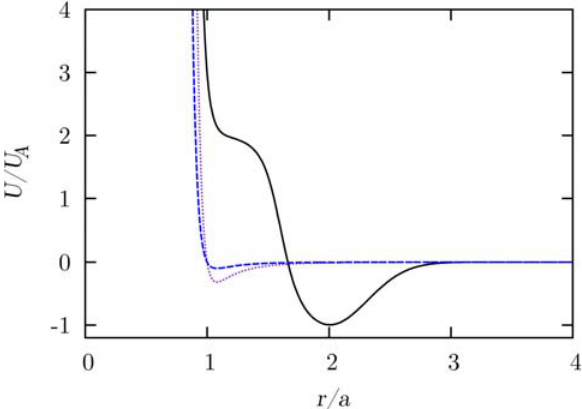
Figure 2: Pair interaction between hydroxyl/water pseudoatoms (solid line), between methyl pseudoatoms (dashed lines) and mixed interaction (dotted